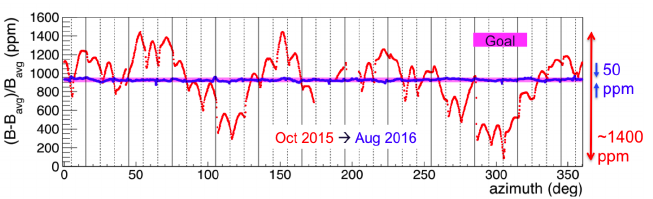
Figure 3: Measurements of the uniformity of the magnetic dipole field before (red) and after (blue)